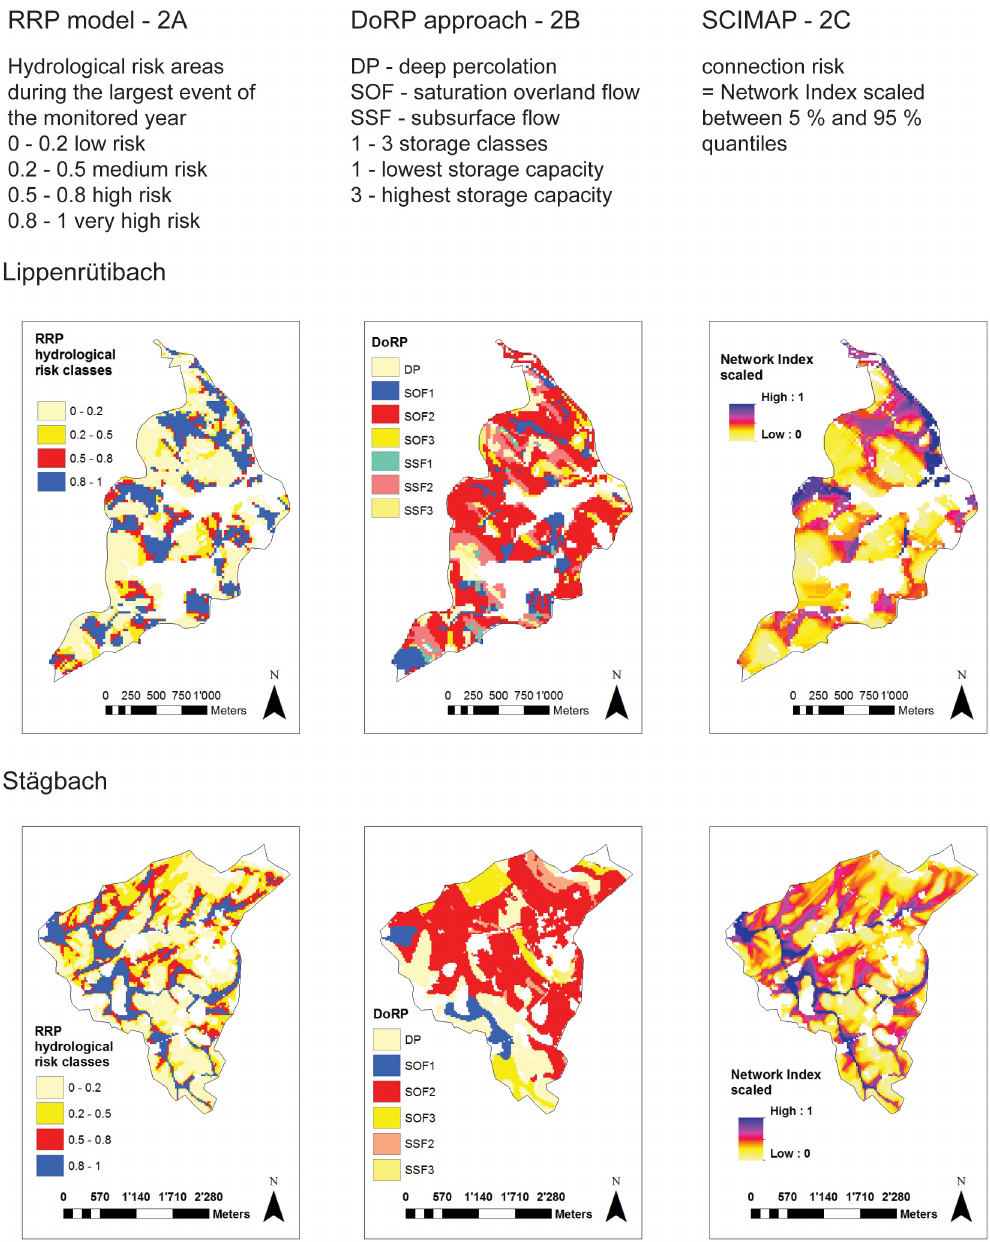
Figure 2. Spatial distribution of hydrological risk areas as determined with the three models for the Lippenrütibach catchment and the Stägbach